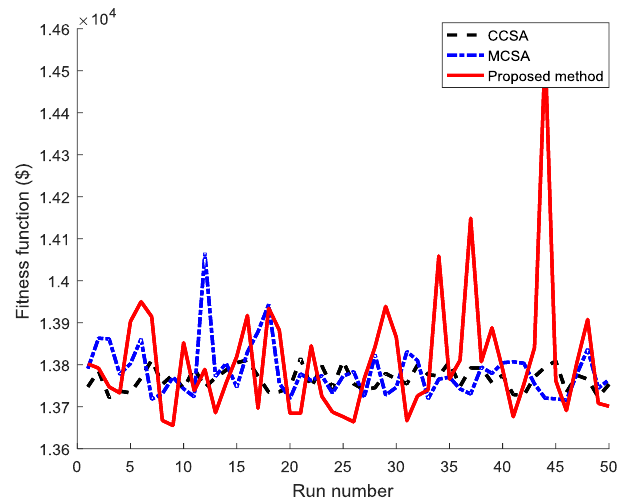
Figure 5. Fitness function values obtained by CCSA, MCSA, and the proposed method over 50 runs for the IEEE 30 buses system.